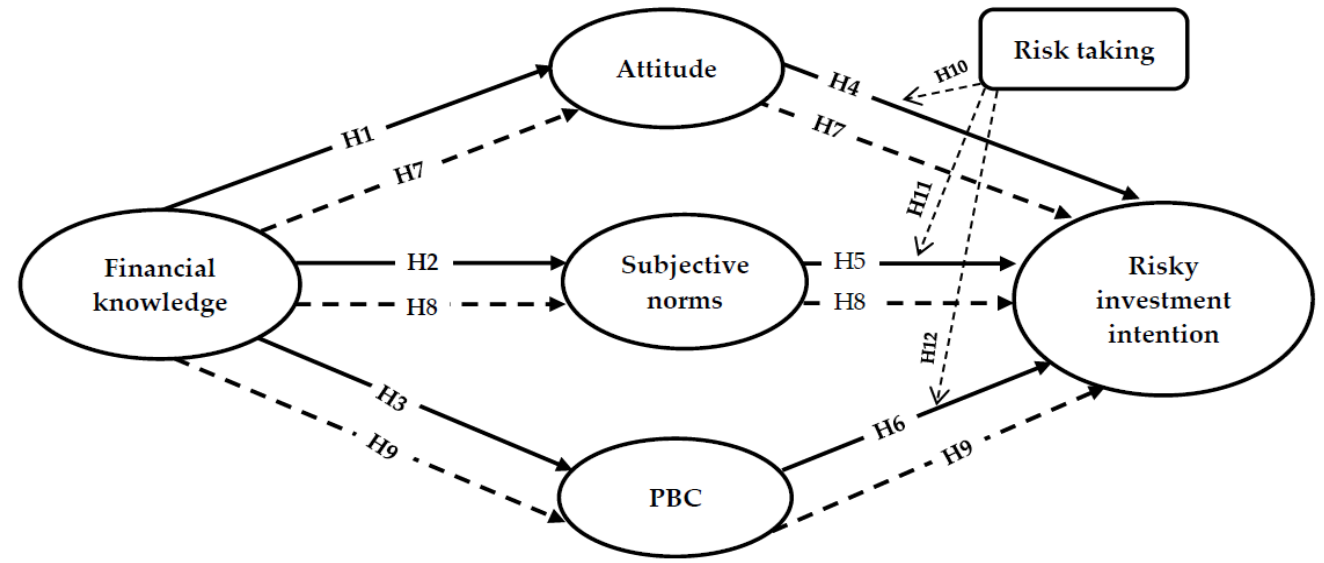
Figure 1. The research